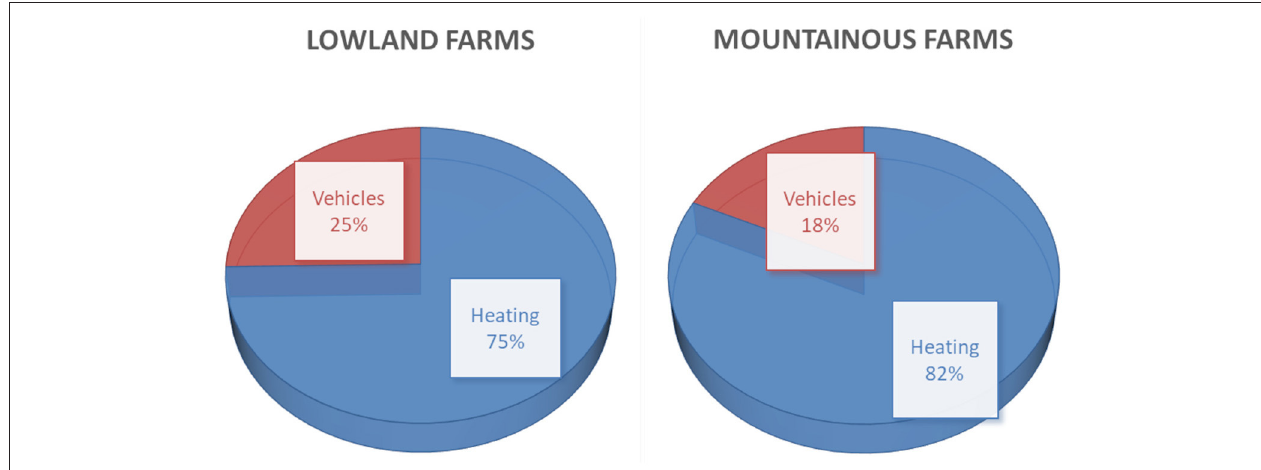
FIGURE 3 | Installed thermal power distribution for lowland and mountainous farms.